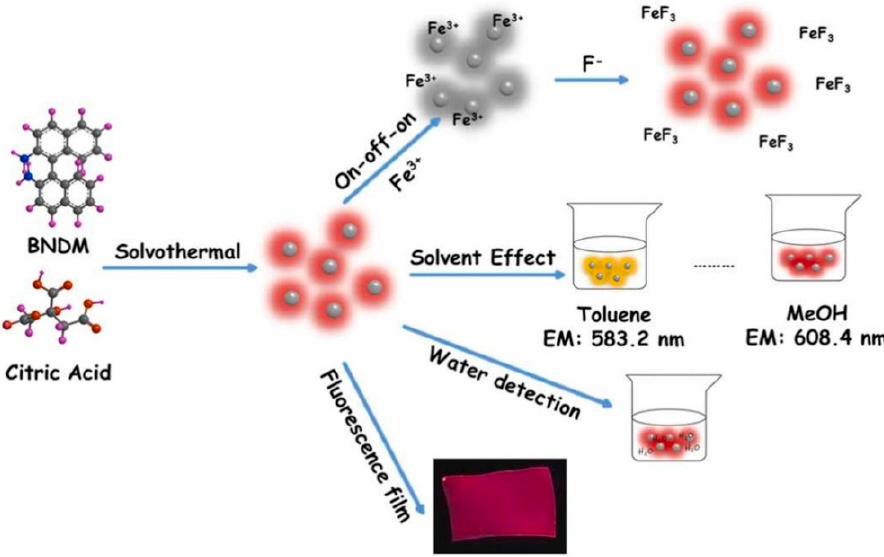
Figure 5. The polarity-sensitive fluorescence effect and Fe 3+ /F − sensing by “on-off-on” fluorescence mechanism (reprinted with permission from [106], 2022, Elsevier).